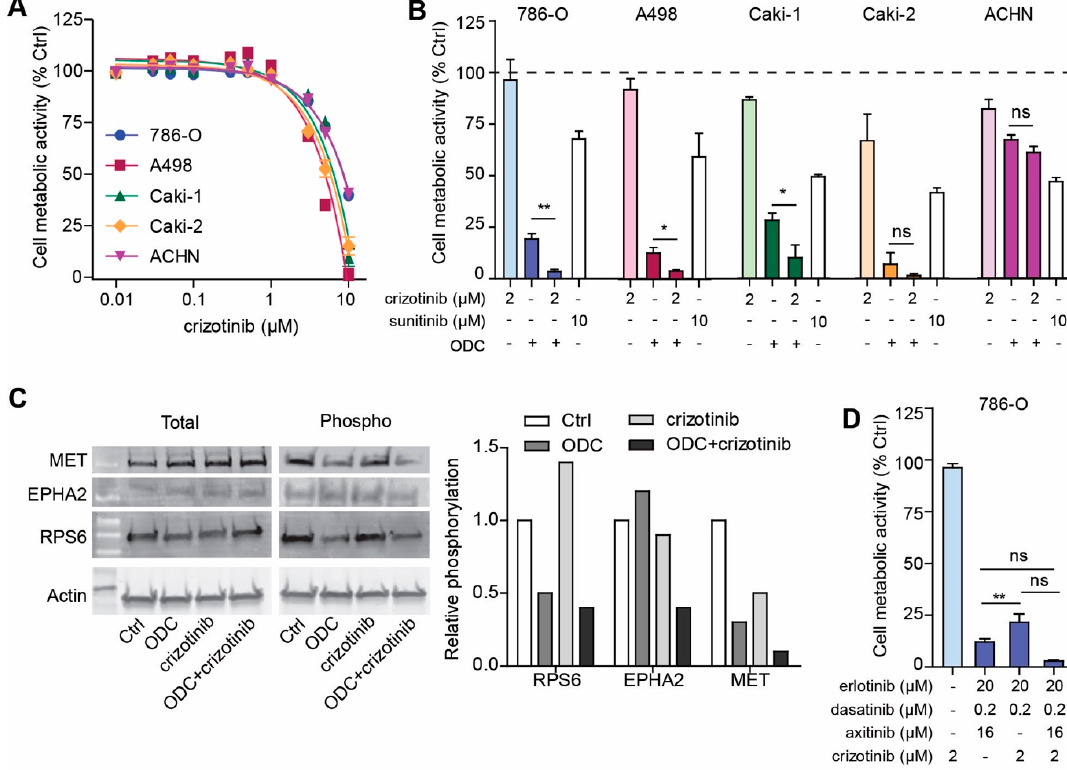
Figure 6. Targeting remaining active kinases further enhances ODC activity. ( A ) Dose response curves of the MET and PTK2 targeting TKI crizotinib. All RCC lines show similar sensitivity to monotherapy of this compound. Experiments (N = 1) were performed in triplicate, and fitted curves are shown. ( B ) 2 µM crizotinib was selected and displayed 5–30% inhibitory activity as single drug. When added to the original ODC, significant further inhibition of cell metabolic activity is observed in 786-O, A498 and Caki-1. Experiments (N = 3) were performed in triplicate, and mean ± SEM are shown. ( C ) Western blot of phosphoproteins after treatment with ODC, crizotinib or the combination thereof. ( D ) Exchange of axitinib for crizotinib does not improve over the original ODC in 2D cultures in 786-O. Experiments (N = 3) were performed in triplicate, and mean ± SEM are shown. ns: not significant, *: p ≤ 0.05, **: p ≤